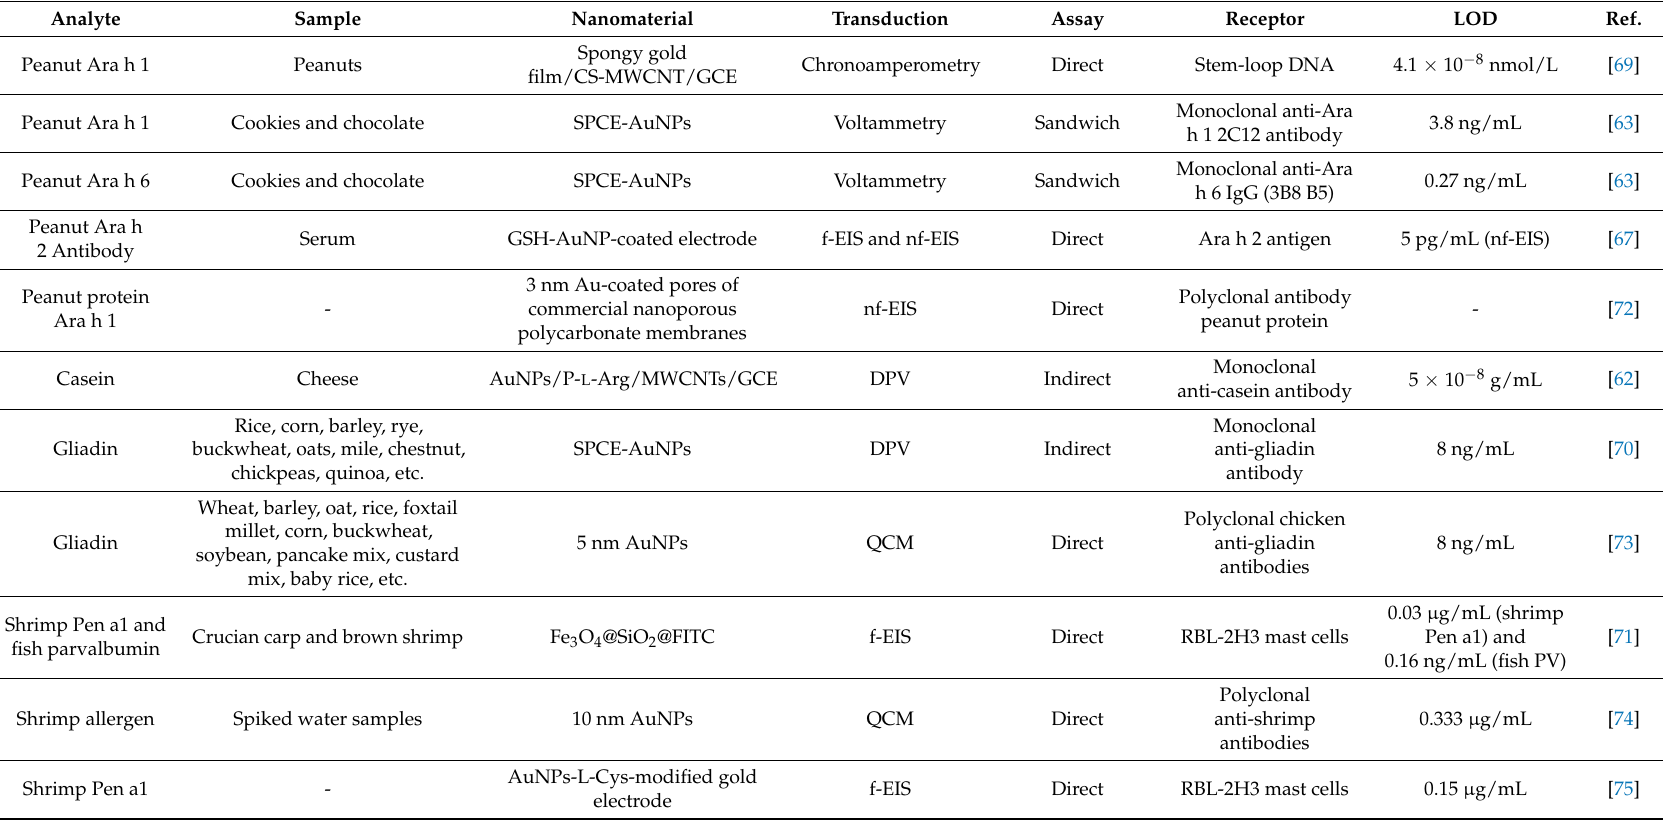
Table 4. Electrochemical and piezoelectric biosensors based on NPs for the detection of food